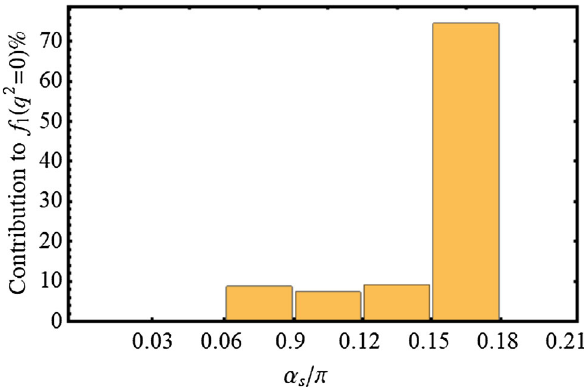
Fig. 5 Contributions to the (cid:2) b → p transition form factor f 1 ( q 2 = 0 ) from different ranges of α s /π for the exponential